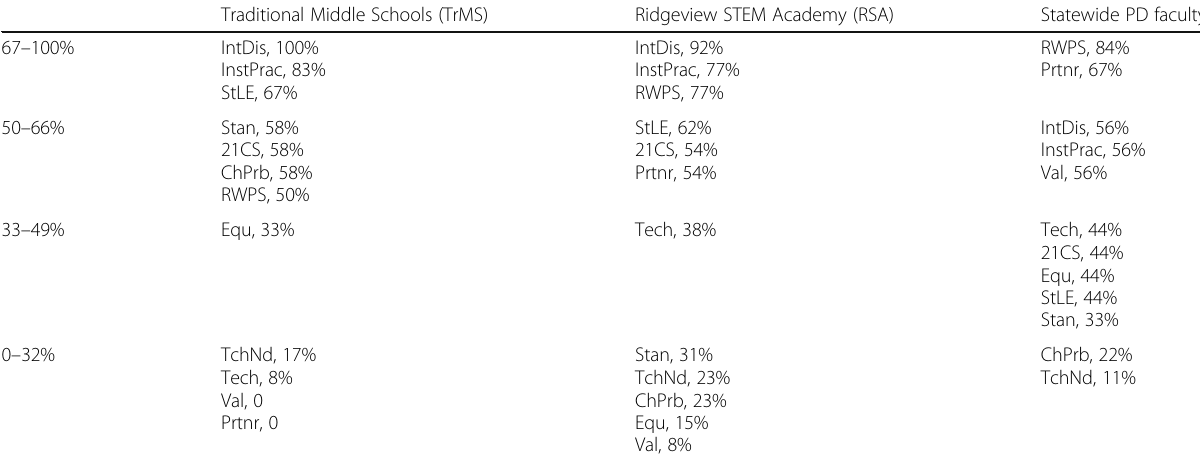
Table 4 Frequency of inclusion of STEM education theme by participants in each context group Traditional Middle Schools (TrMS) Ridgeview STEM Academy